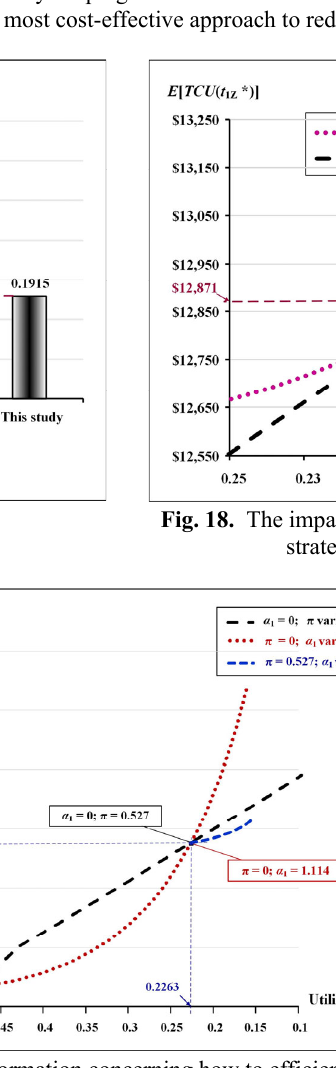
Fig. 19. Decision-support information concerning how to efficiently reduce